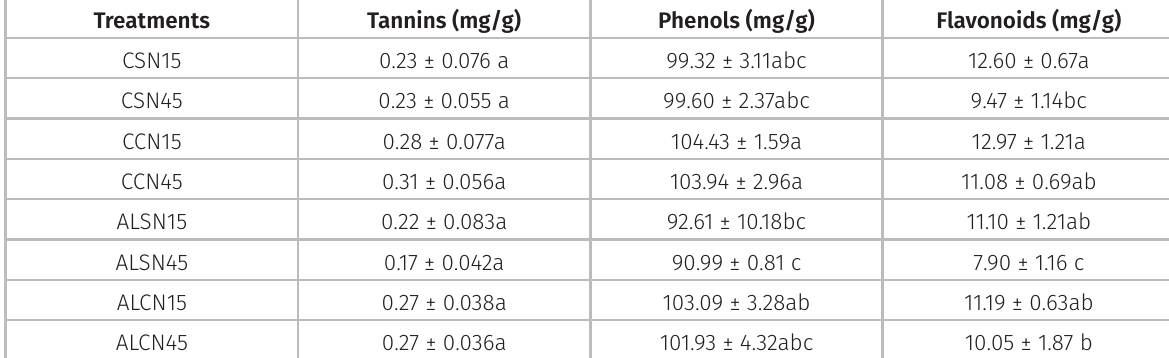
Table II. Amount of bioactive compounds (tannins, phenols and fl avonoids) in ethanol extract of guava leaves, inoculated (AL) or not (C) with A. longula , in the presence (CN) or absence (SN) of M. enterolobii , at 15 and 45 days after inoculation of the